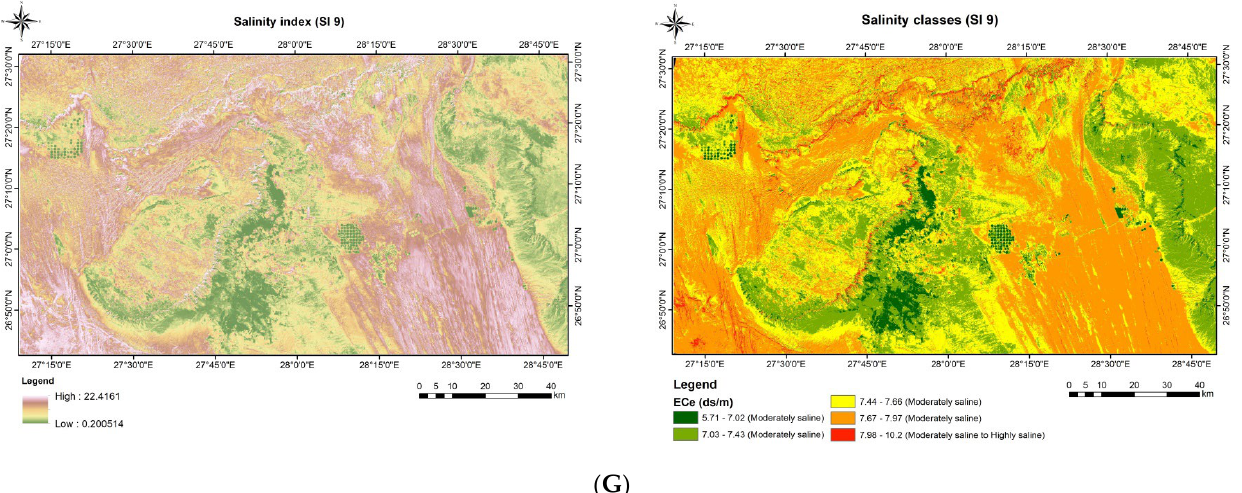
Figure 3. Soil salinity maps of the study area produced from salinity indices derived from Landsat-8 (OLI) spectral bands: ( A ) = SI 1; ( B ) = SI 2; ( C ) = SI 5; ( D ) = SI 6; ( E ) = SI 7; ( F ) = SI 8 and ( G ) = SI 9.